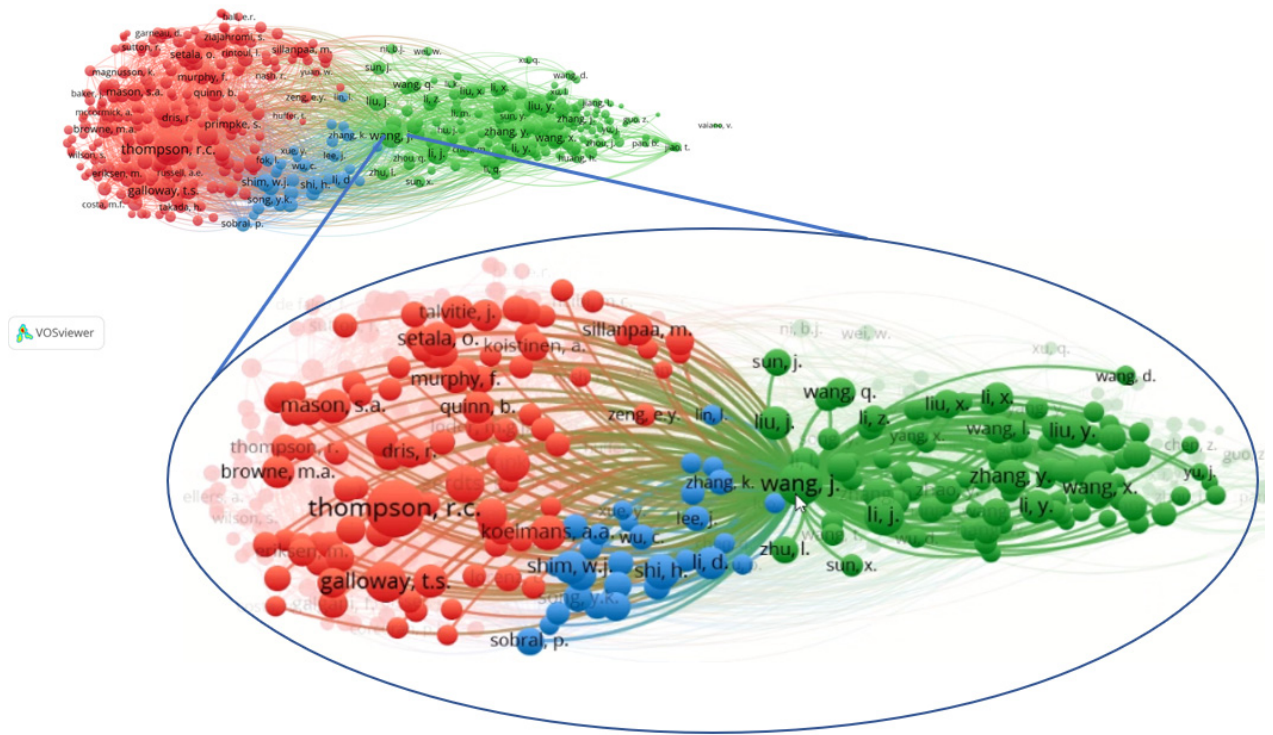
Figure 8. Co-citation map resulting from the citing analysis of the authors which have been cited more than 50 times. The size of a dot is related to the TLS, i.e., the number of times that the related author appears, along with any other author- in the list of the references of the examined papers. Inset —zoom visualization of the authors linked to Wang J. An interactive visualization of the map is available at https://bit.ly/2UqMBHH. Accessed date: 30 May 2021.